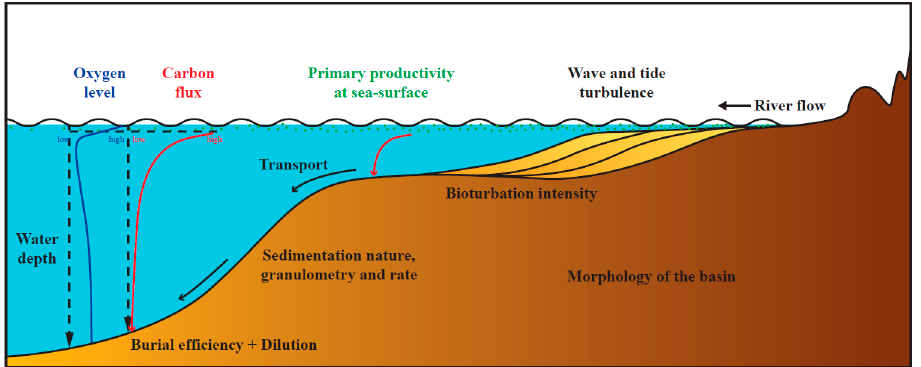
Figure 2. Main processes affecting organic matter history, as simulated in DionisosFlow Organic-Rich Sediment (modified after Tyson [26]). Primary productivity at the sea-surface is the first step in the production of organic matter and is dependent on nutrient availability, which is itself dependent on climate, upwelling, run off, vegetation cover and morphology of the catchment area. This organic matter, which is exported in the form of flocs settling from the photic zone (carbon flux), is partly consumed by other organisms in the food-chain. Once the organic remaining matter reaches the seafloor, it is eventually transported and buried. The amount of organic matter preserved after the first few meters of burial (i.e., during early diagenesis) is called burial efficiency; this parameter is mainly controlled by the sedimentation rate and local oxygen level/redox conditions. Modelling of these processes allows us to compute a theoretical initial TOC after the first few meters of burial of the marine organic matter fraction.